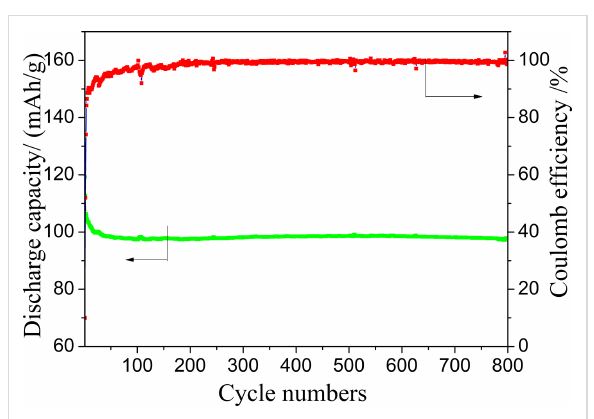
Figure 14: Cycle performance of the LiFePO 4 //Li 4 Ti 5 O 12 all-fiber battery at 1C.